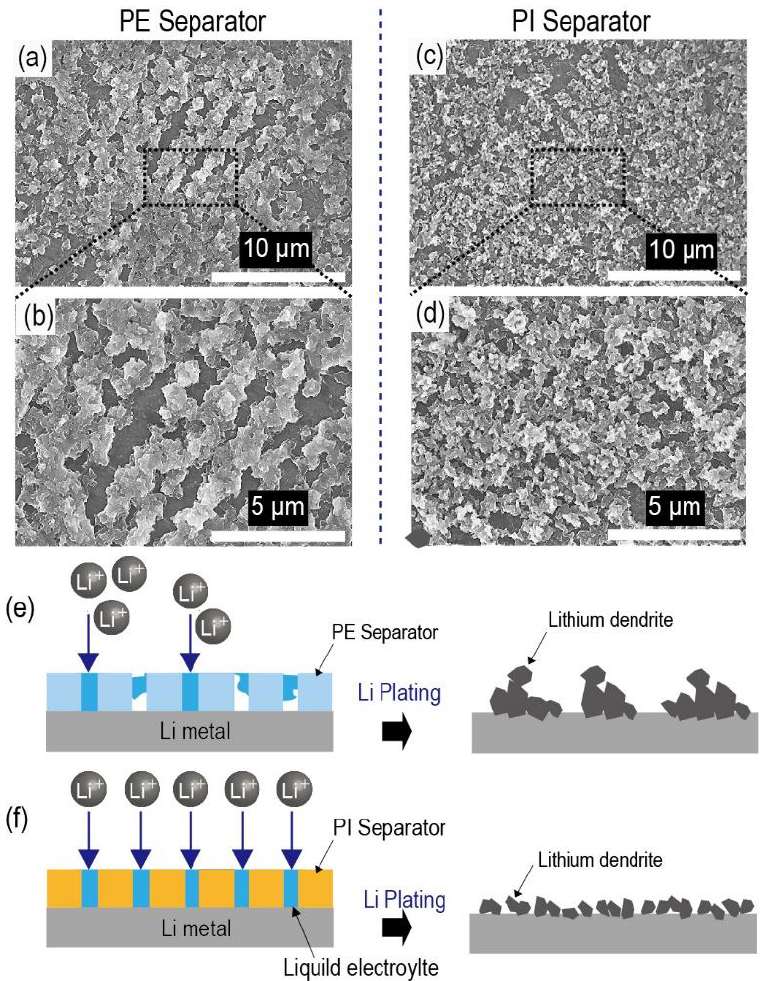
Figure 7. Scanning electron microscopy (SEM) images of the Li-metal surface after Li plating (0.5 mA cm – 2 for 30 min), disassembled from the Li/Li symmetric cells containing different types of separators (( a , b ) bare PE separators and ( c , d ) porous PI separators). Schematic figures of the Li plating mechanism according to the types of separators: ( e ) bare PE separators and ( f ) porous PI separators.